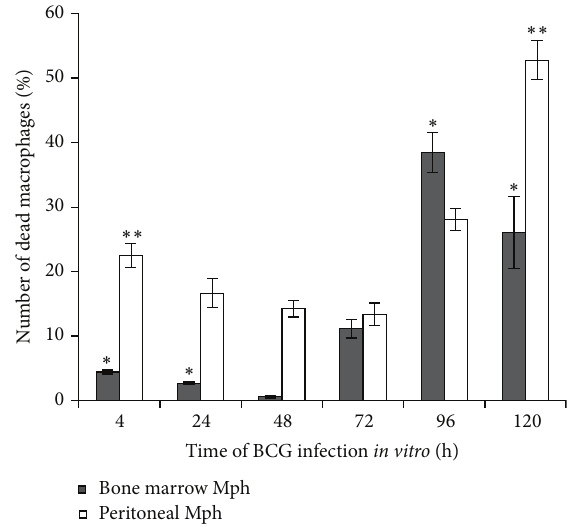
Figure 4: The number of dead cells is expressed as a percentage of the total number of infected macrophages (Mph) in the cultures of mouse bone marrow and peritoneal macrophages following infection with the BCG vaccine in vitro and after culture for several hours. Data are expressed as the means ± SEM from three independent experiments. In each experiment, more than 1000 cells were analyzed at each time point. P < 0.05 (comparisons of the number of dead bone marrow Mph ∗ for the following time points (in hours): 4 and 24 versus 96 and 120; dead peritoneal Mph ∗∗ for the following time points (in hours): 4 versus